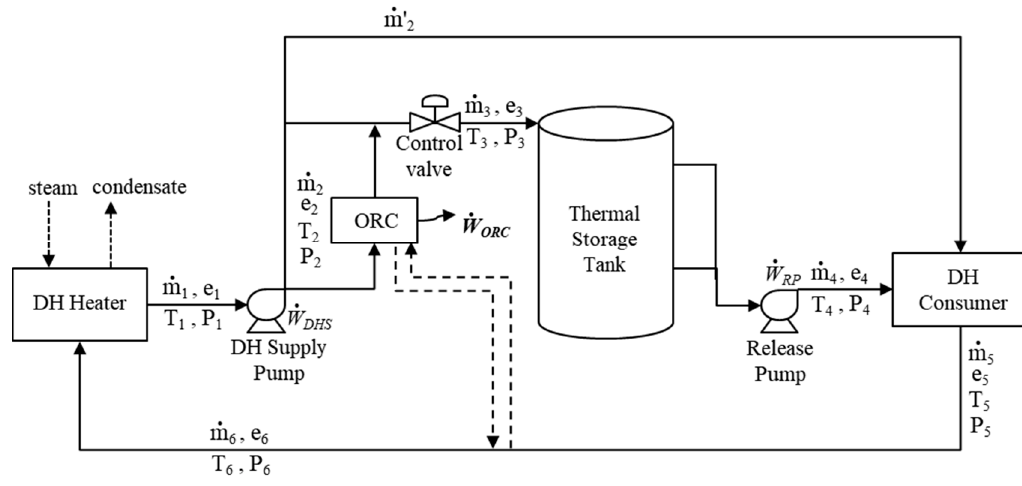
Figure 5. Configuration of organic Rankine cycle.